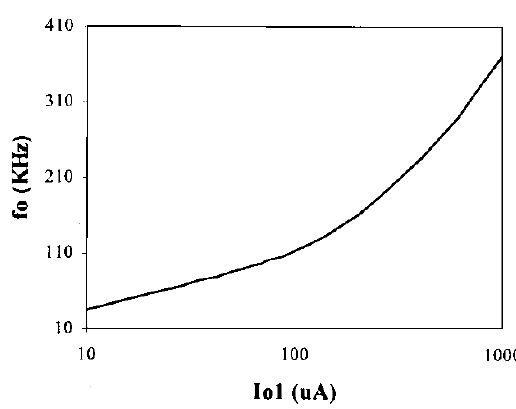
FIGURE 3 Electronic frequency tuning for C 1 ¼ C 2